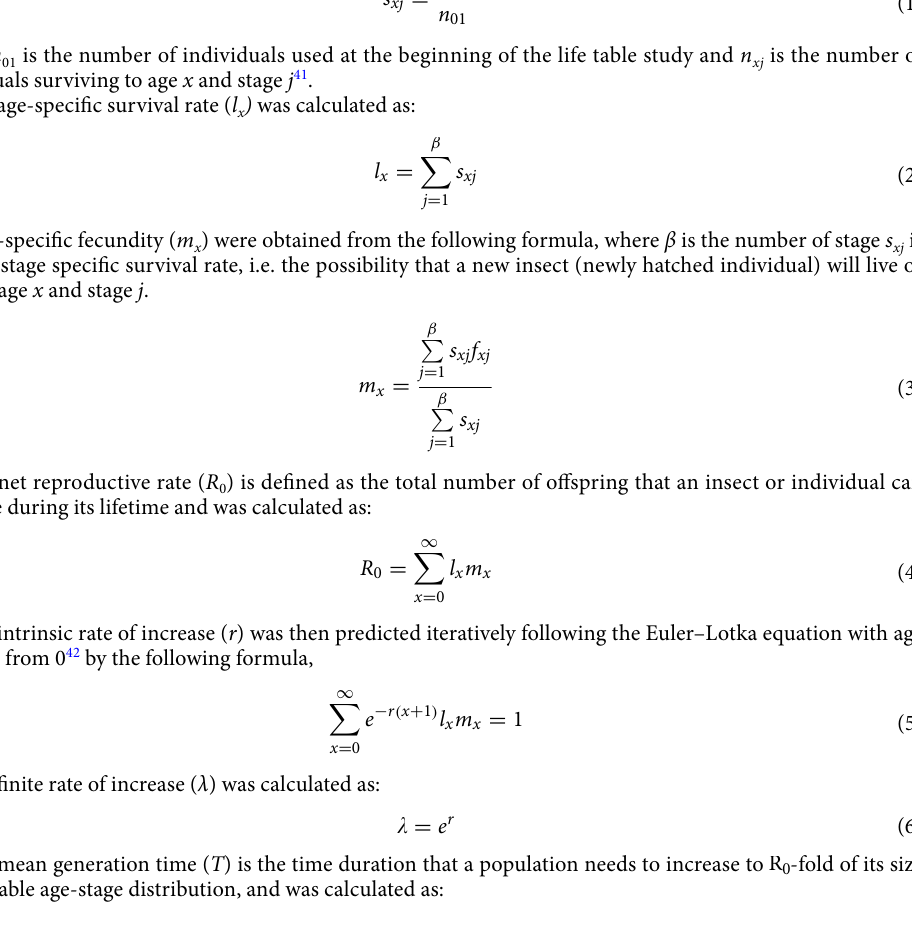
table trials. Hatchlings were transferred to new Petri dishes and reared on sufficient eggs until pupation. The duration and viability of the individuals were recorded daily. Instar changes were evaluated based on the exuvia presence. The experiment was performed at four different temperatures (i.e., 15, 20, 25 and 30 °C), 70 ± 5% RH, and 16:8 (Light: Dark) h photoperiod. The temperature regimes tested here represent the thermal conditions that H. axyridis encounters in different protected plantations and field crops in tropical and temperate regions 38 . Experimental cohorts were generated as fifty individuals per temperature. Survival rate and time to hatch were recorded for each stage in each temperature treatment. The number of surviving larvae and the total develop- mental period from larva to pupa were also recorded. Predation was recorded for both larval and adult stages of the predator. After eclosion, the predator larvae were fed with S. litura eggs until pupation. In addition to this, male and female adults that emerged from the pupae on the same day from a given temperature were numbered and coupled in the insect boxes. Adult pairs were monitored to ensure that mating occurred, and time allowed for mating event was ~ 10 h a day, and no prey was made available during mating events throughout the trial duration. One or a few matings are reported sufficient for coccinellids females to fertilize all eggs. No eggs provi- sion during mating events was meant to avoid any potential disturbance during this activity. After mating, the pairs were separated and shifted cautiously to their respective Petri dishes with eggs. The life span of an adult male is shorter than female, hence extra pairs of insects were raised in parallel to supply supplementary males for mating depending on the need at each temperature, simultaneously. The number of eggs laid per female includ- ing the cannibalized ones and adult mortality was noted twice daily until all female adults died. About 400–500 eggs of S. litura were supplied daily to the larvae and adults on cotton leaves. The counted numbers of S. litura eggs were fed to each stage of the predator. Predation data were recorded daily as numbers of eggsdamaged or consumed. Petri dishes and boxes were cleaned daily with 75% ethanol. Data analysis. The data were analyzed by using TWOSEX-MSChart 39 according to age-stage, two-sex life table theory 14,40 . The age stage-specific survival rate ( s xj ), age-specific survival rate ( l x ), age-specific fecundity (